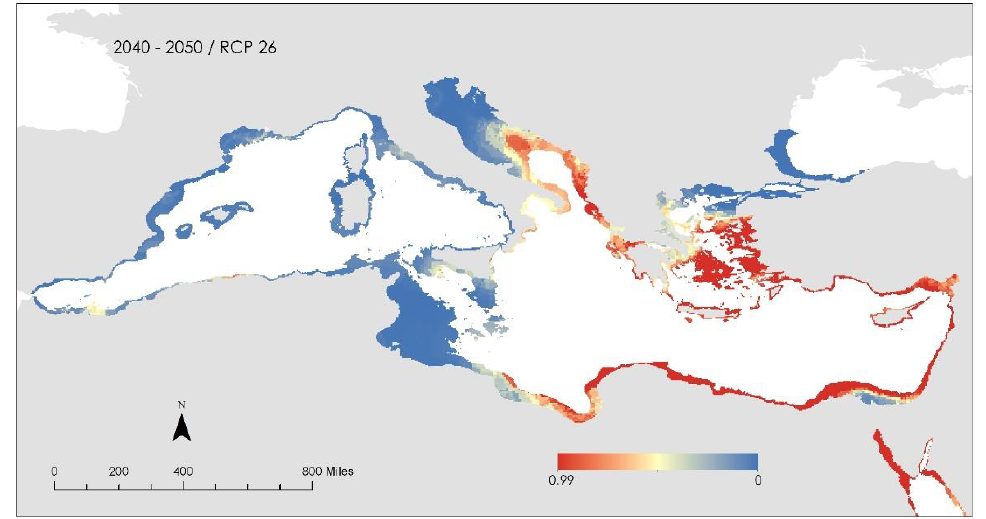
Figure 2. Lionfish potential distribution under RCP26 for the period 2040 – 2050.